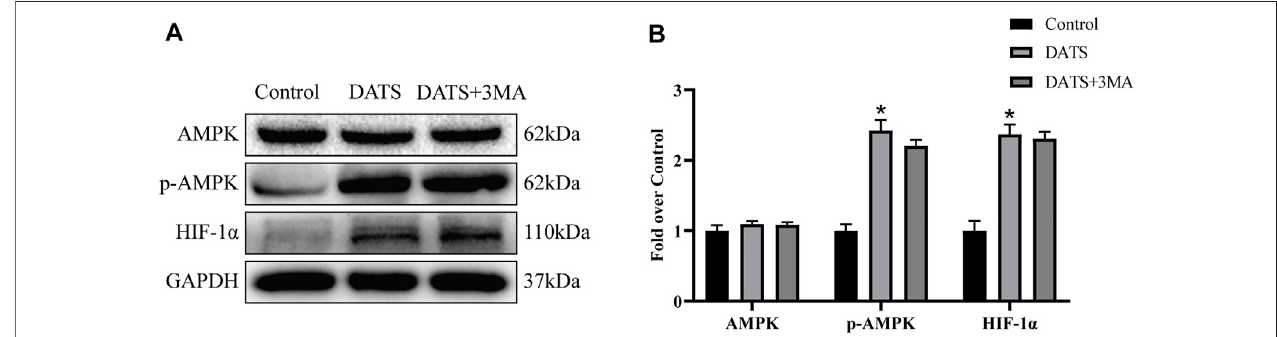
FIGURE 8 | DATS promotes angiogenesis and reduces oxidative stress through the AMPK pathway. (A) Western blotting of AMPK signaling pathway markers, AMPK, p -AMPK, and HIF-1 α in the control, DATS, and DATS+3MA groups. All the gel electrophoresis experiments were carried out under the same experimental conditions. (B) Statistical chart ofthe quanti fi cation ofAMPK, p -AMPK, and HIF-1 α expressions inthe perforator fl aps. * p < 0.05, vs. control group; # p < 0.05, vs. DATS group. The obtained data were expressed as means ± SEM, n = 6 for every group. DATS, diallyl trisul fi